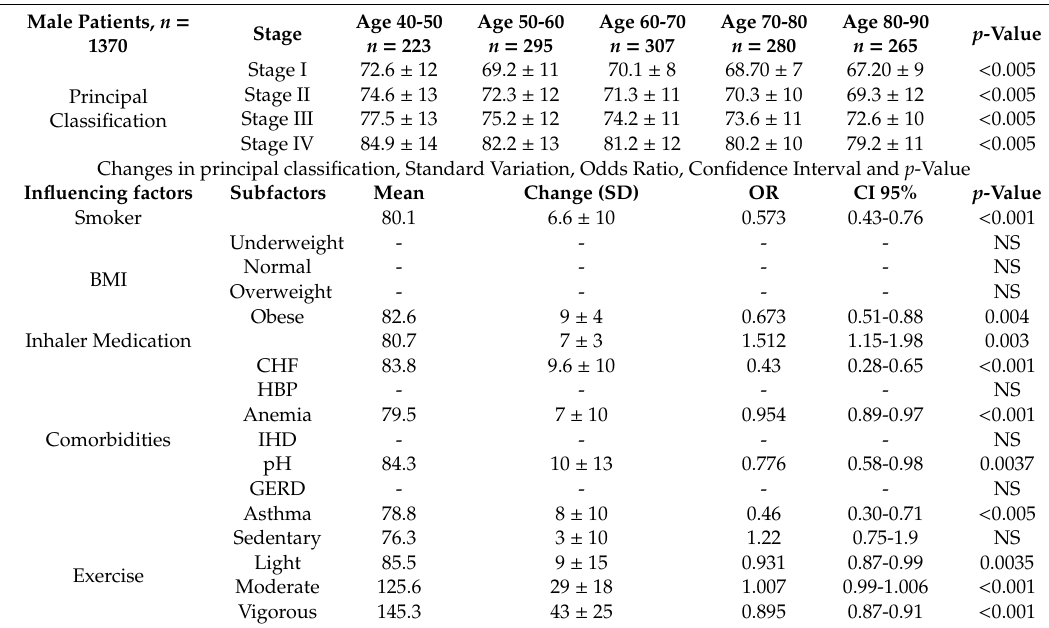
Table 1. Heart rate